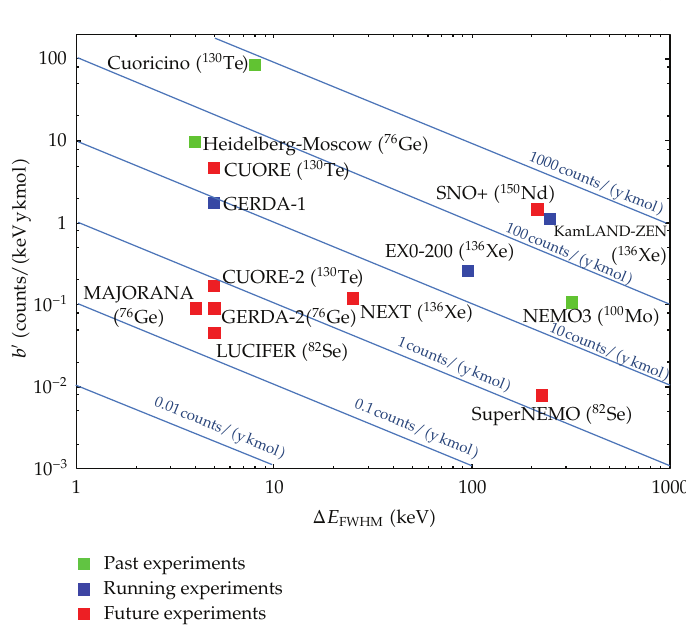
Figure 12: Comparison of technologies/experiments on the basis of the absolute background level they have achieved (cid:2) green and blue points (cid:3) or promise to achieve (cid:2) red points (cid:3) , disentangling the role of the energy resolution Δ E FWHM from that of the specific background b (cid:8) (cid:2) related to the number of candidate nuclei rather than to the detector (cid:2) or source (cid:3) mass (cid:3)